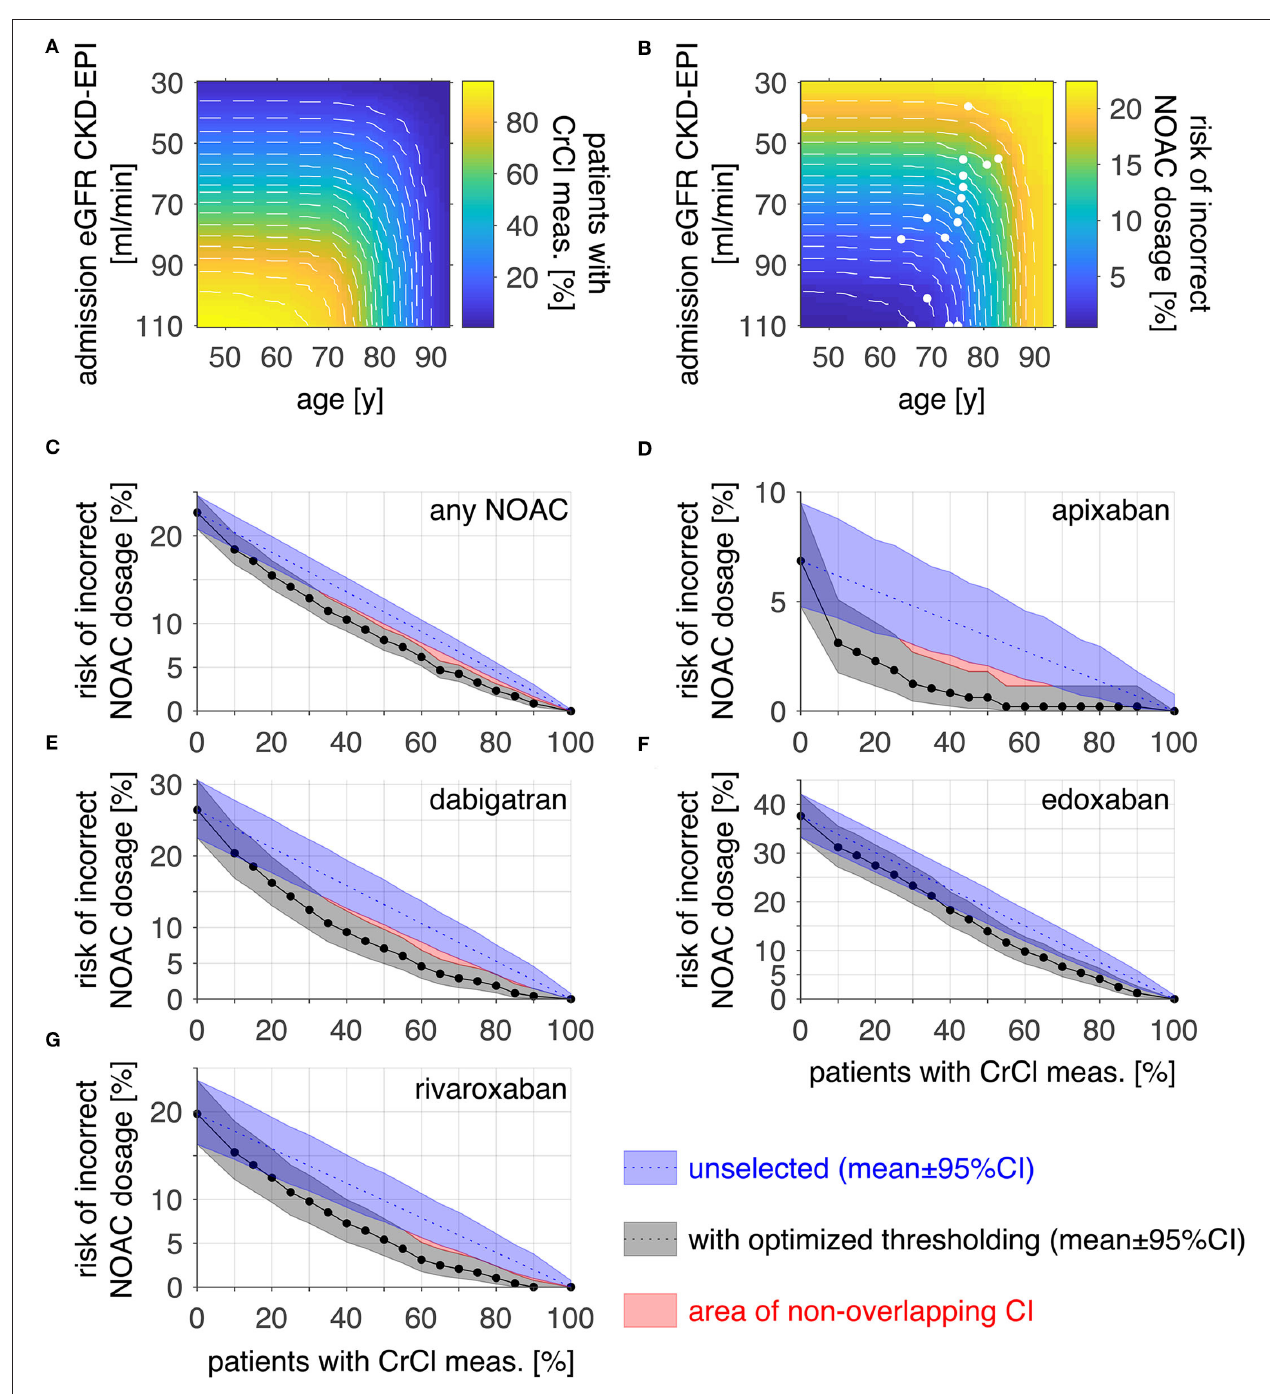
FIGURE 2 | Optimizing thresholds for risk reduction by CrCl measurement. The proportion (A) and risk of incorrect NOAC dosage [ (B) , any NOAC] of the patients above an admission eGFR CKD-EPI and below an age threshold are displayed as color-coded images. Threshold combinations of equal proportions [white dashed plots in (A) ] were evaluated for the lowest risk of incorrect dosage [white points in (B) ] to find the optimal thresholds for risk reduction. (C) displays the risk of incorrect NOAC dosage within the patient population when performing CrCl measurements across a portion of the population for an unselected (blue) group and a selection fulfilling the threshold criteria in (B) (gray). To reduce the risk of incorrect NOAC dosage in the whole population below 5%, the number of patients with additional CrCl measurement would have to be 65% after thresholding and 80% for unselected patients for any NOAC. (D–G) shows the corresponding analysis for apixaban (10 vs. 30%), dabigatran (60 vs. 85%), edoxaban (80 vs. 90%), and rivaroxaban (55 vs. 75%). Risk data are plotted as mean ± 95% CI, red areas denote non-overlapping CI; meas.,